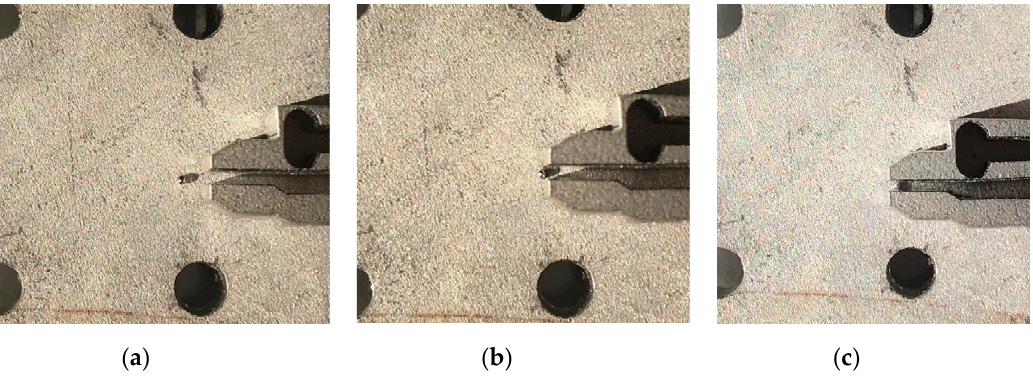
Figure 14. ( a , b ) Approaching and ( c ) grasping the micro-object.